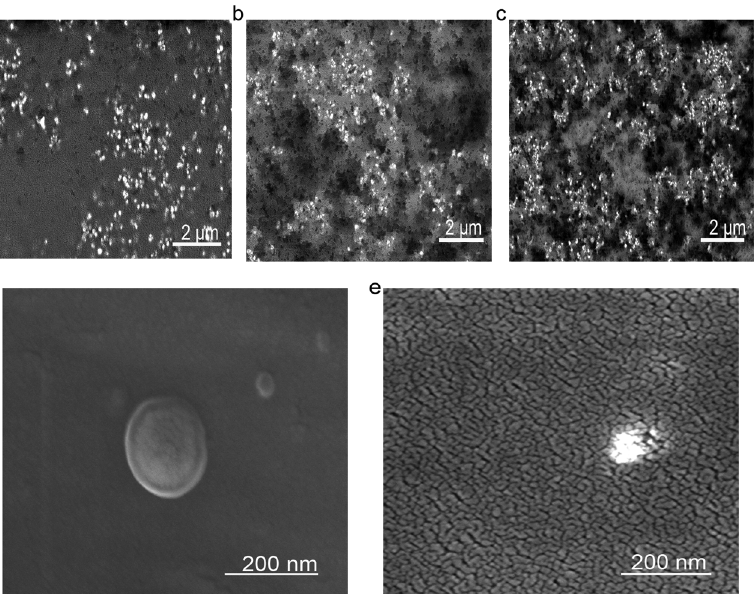
Figure 7: SEM images of the ZnO - LDPE fi lms. ( a ) 4% ZnO NP; ( b ) 5% ZnO NP; ( c ) 6% ZnO NP; ( d ) the high magni fi cation of 6% ZnO NP fi lm cooled with ambient temperature of post hot press; ( e ) 6% ZnO NP fi lm quenched of post hot